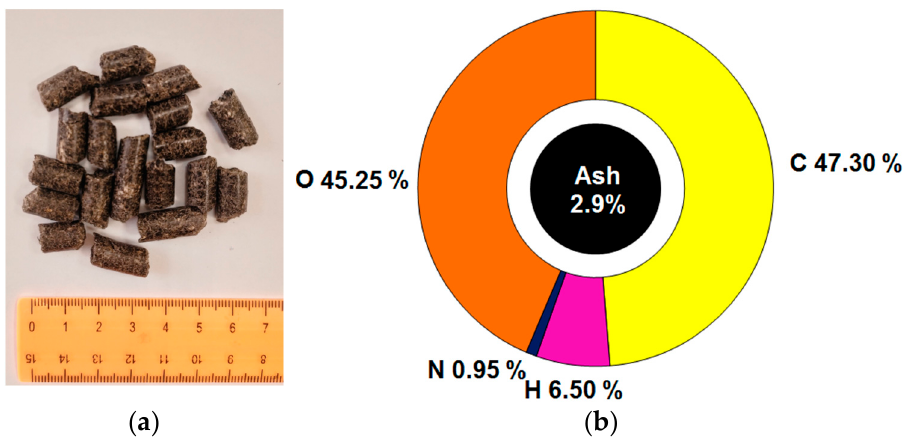
Figure 1. Sunflower husk pellets: ( a ) photography; ( b ) chemical composition (ultimate analysis)